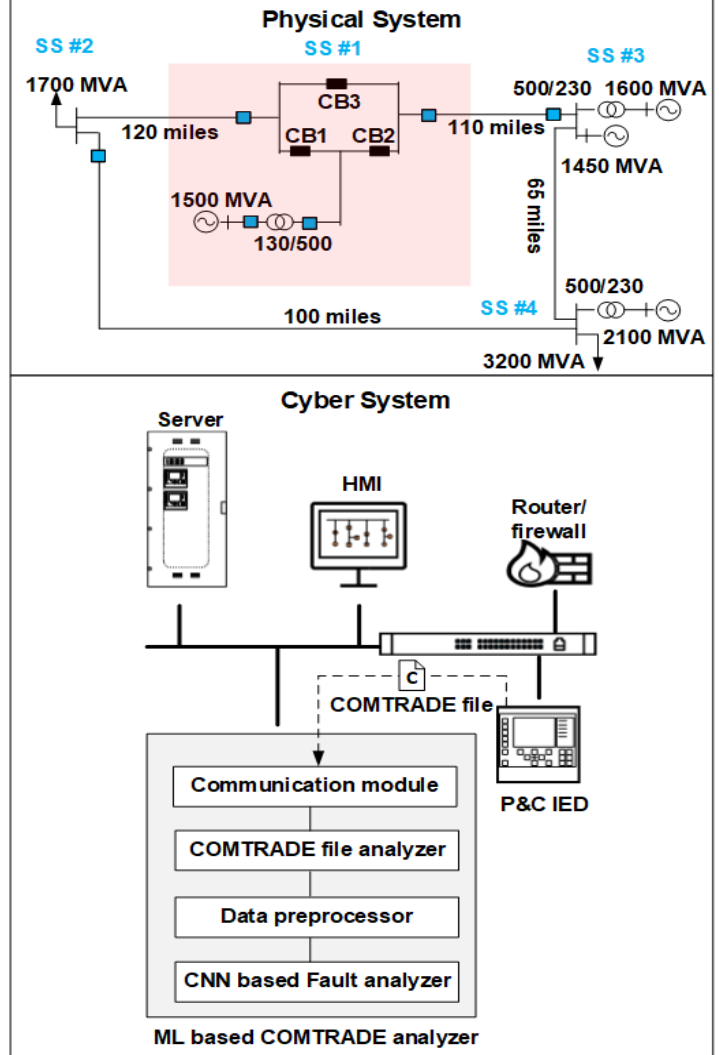
Figure 5. 500 kV cyber-physical test